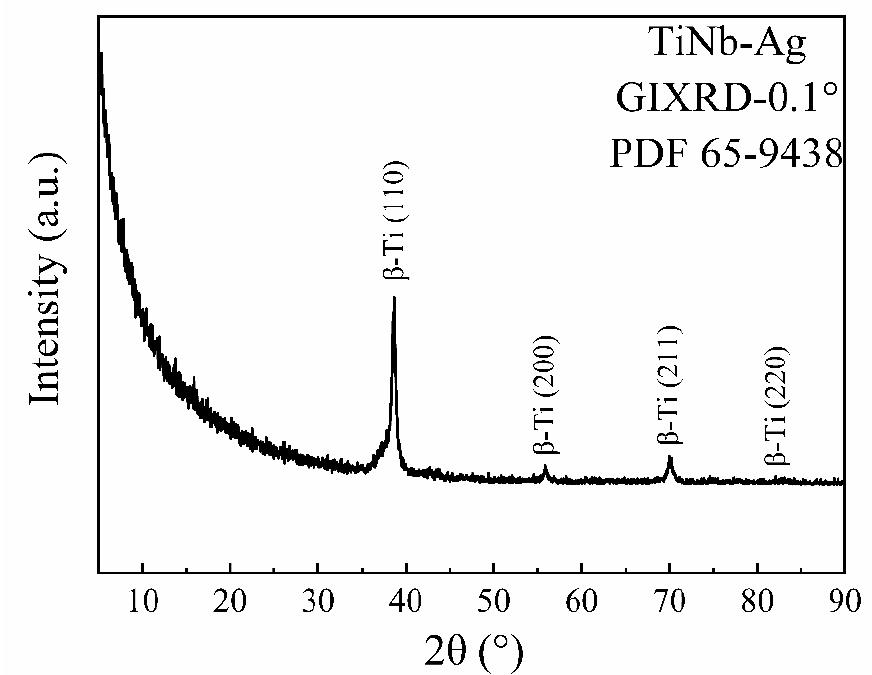
Figure 4. Grazing incident X-ray diffraction pattern (incident Angle was 0.1°) of the Ag-implanted layer with dose of 10 × 10 16 ions/cm 2